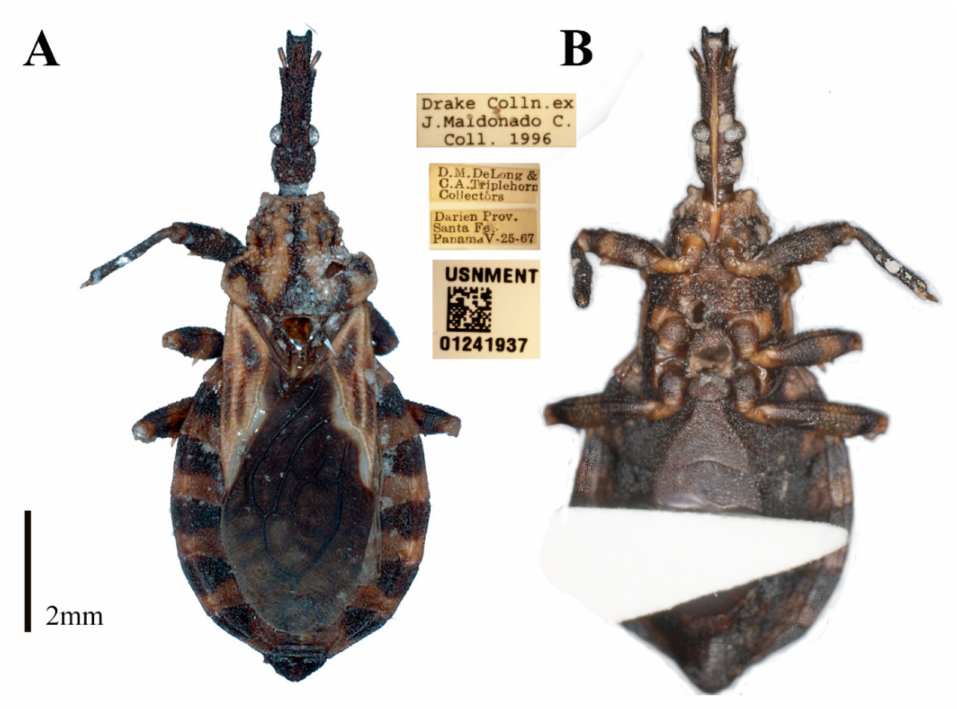
Figure 3. Belminus santosmalletae sp. n. female ( A ) dorsal view and ( B ) ventral view, and three labels with information about collection, collectors, date, local, and deposit voucher